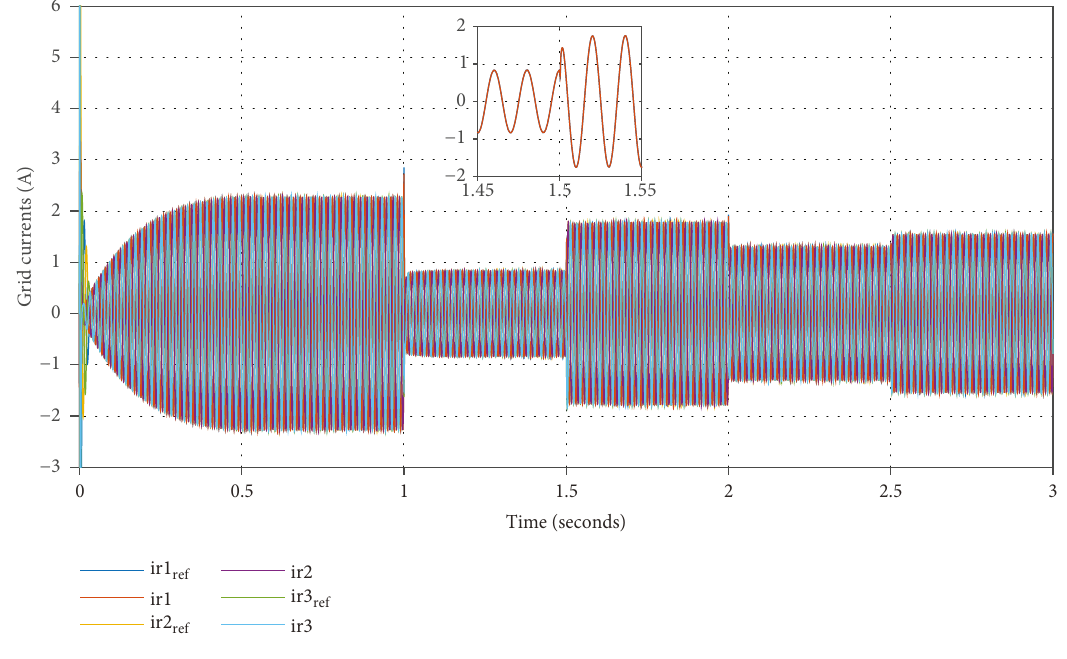
Figure 13: Grid currents (TLBO-FOPID).